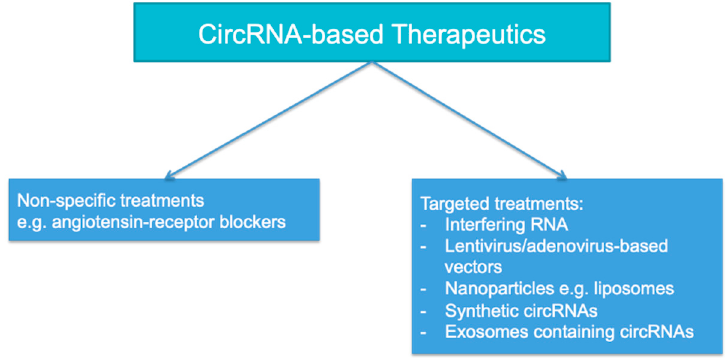
Figure 3. The therapeutic options for acute kidney injury (AKI) based on circRNA.